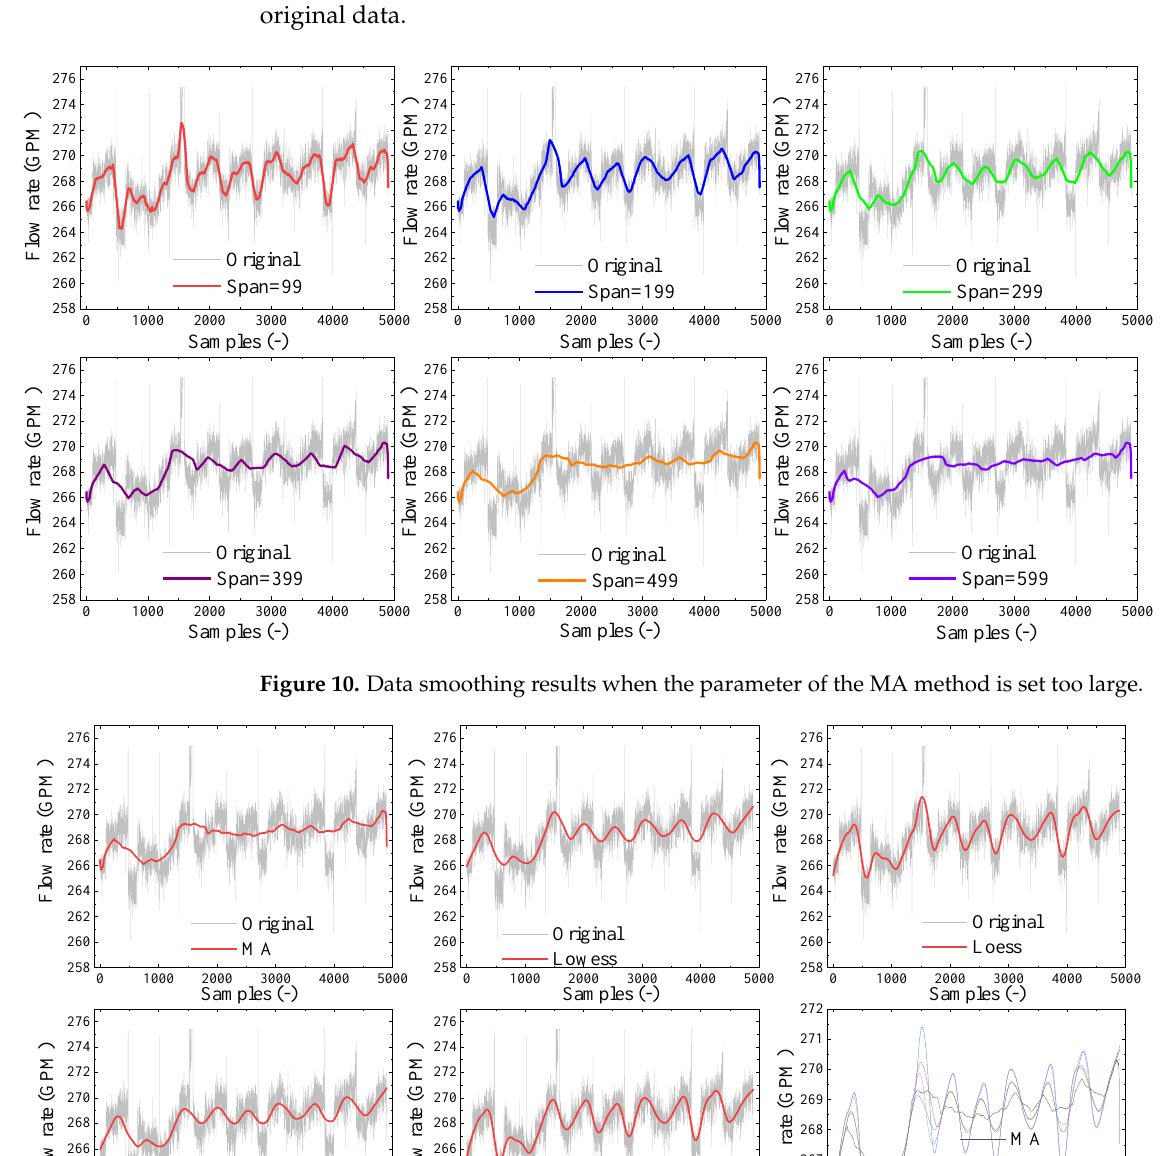
Figure 10. Data smoothing results when the parameter of the MA method is set too large.